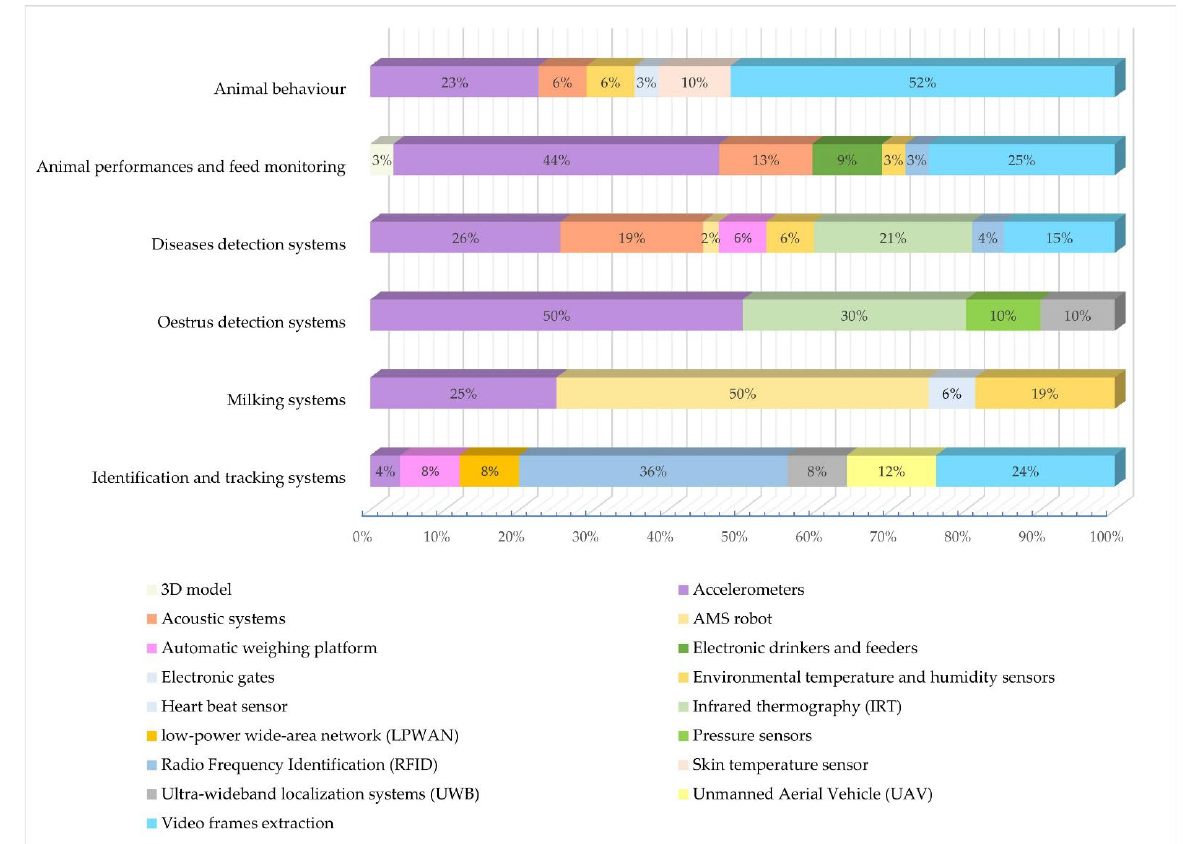
Figure 1. Percentage of the most used sensors per each area of interest in PLF.